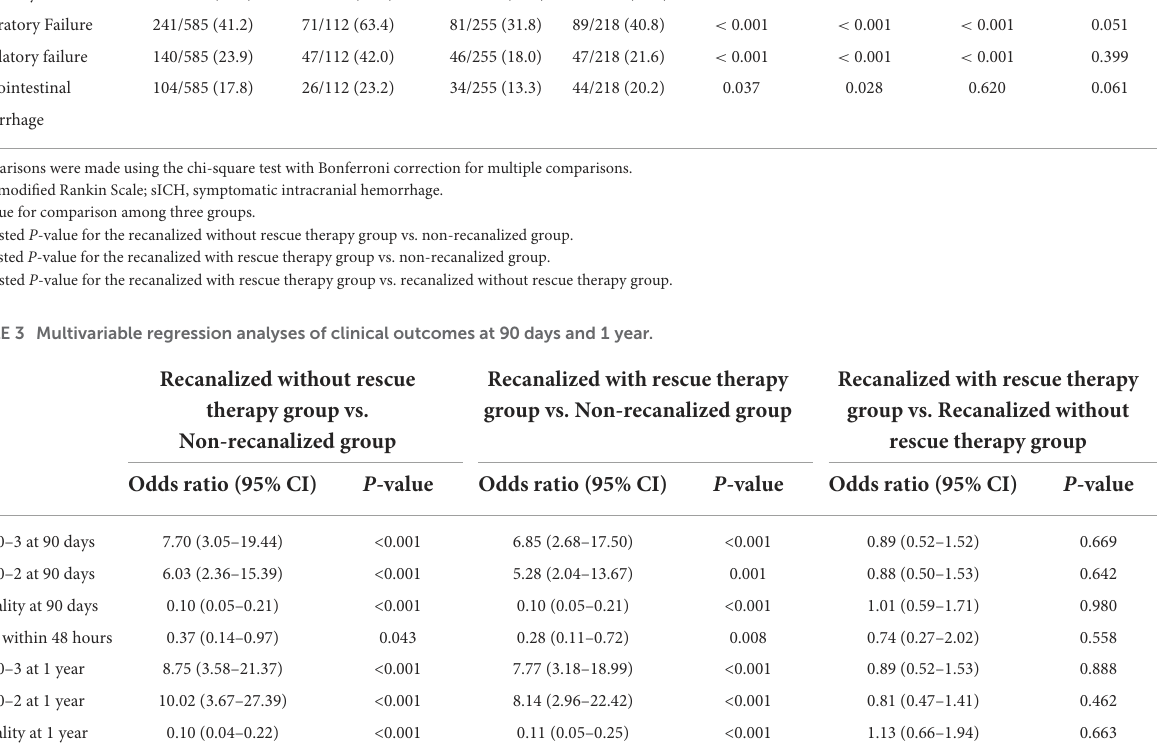
P -value a P -value b P -value c P -value d Overall Non- Recanalized Recanalized recanalized without with rescue group rescue therapy therapy group group